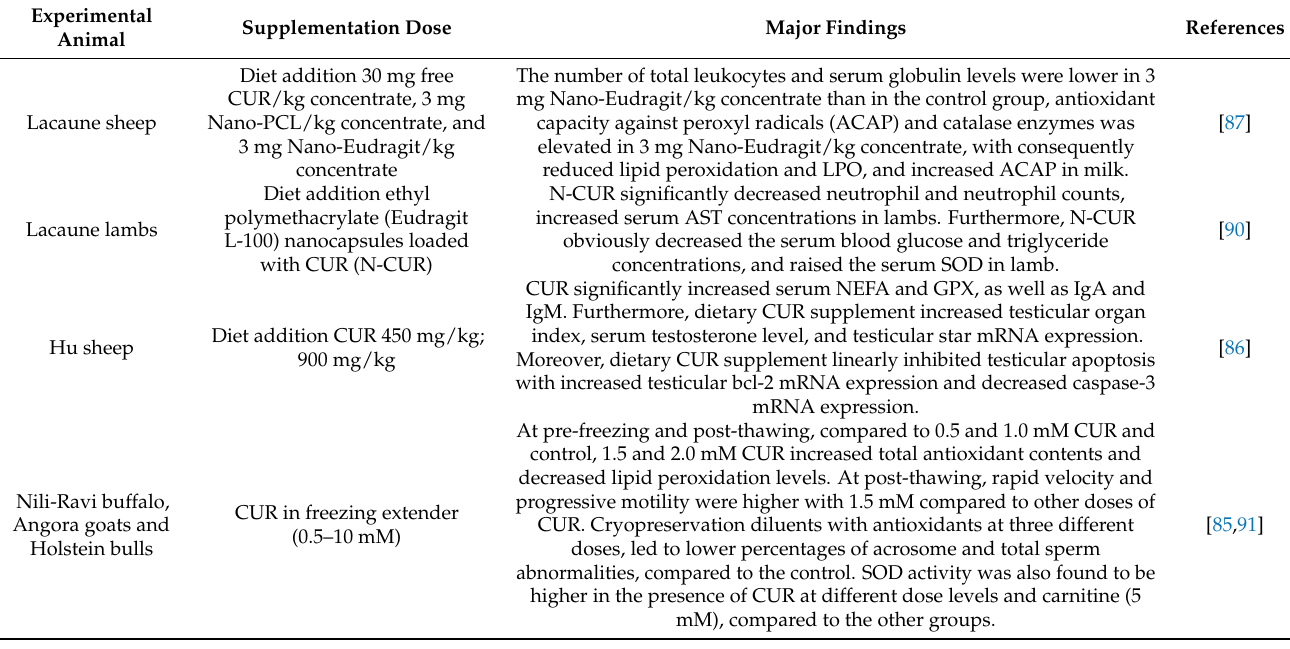
Table 4. Application effect of CUR in ruminant farming as a plant-derived feed